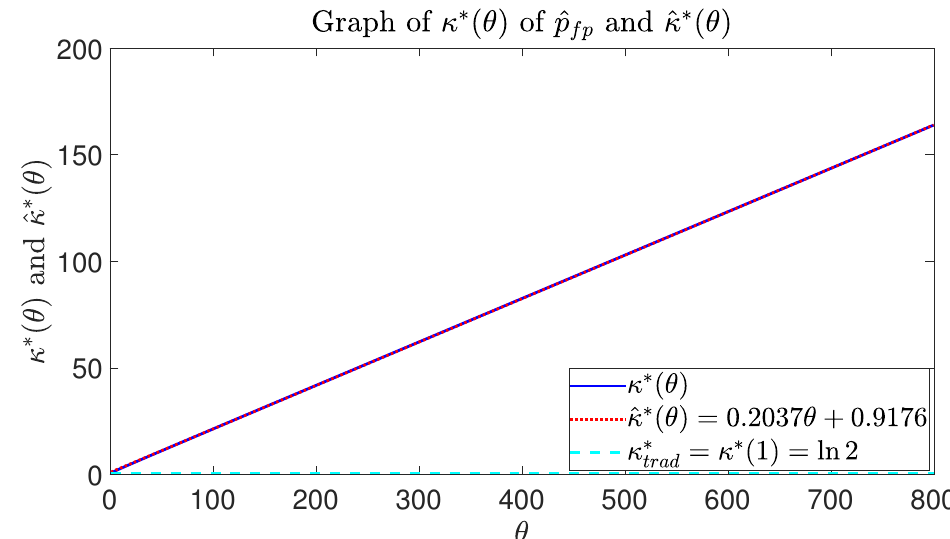
Figure 5. The functions κ ∗ ( θ ) and ˆ κ ∗ ( θ ) as a function of θ .